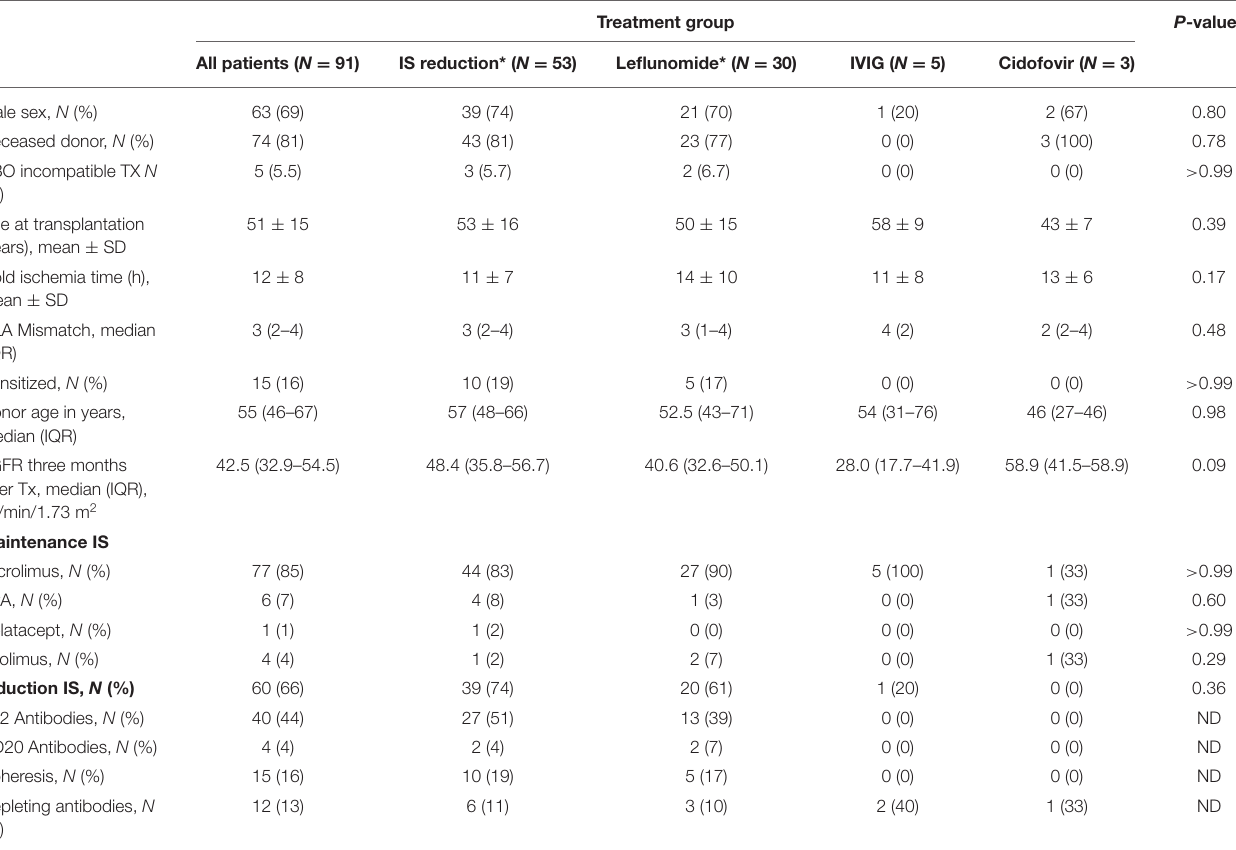
TABLE 1 | Demographic and clinical characteristics of the study population.